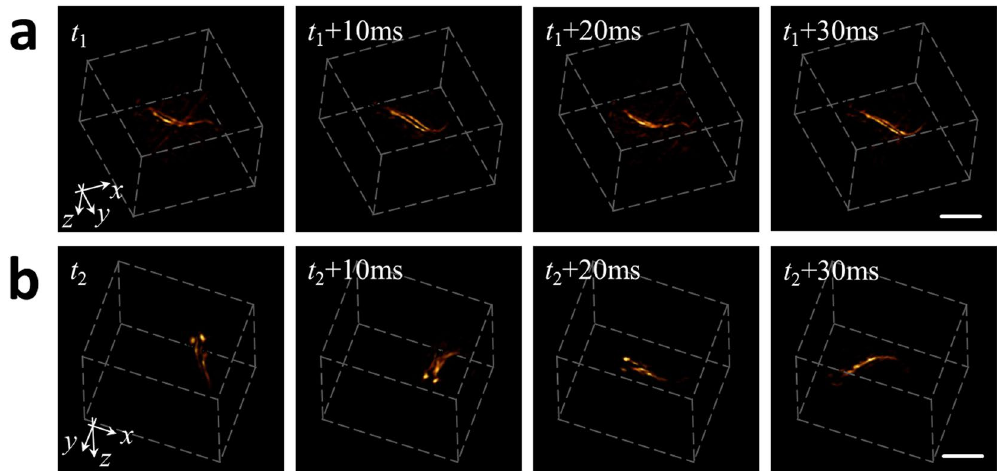
Figure 4. Time-lapse 3D images acquired from a freely swimming zebrafish recorded at a frame rate of 100 volumes per second. The shown sequences correspond to two portions of the movie having smooth ( a ) and abrupt ( b ) movements. Scalebar – 1